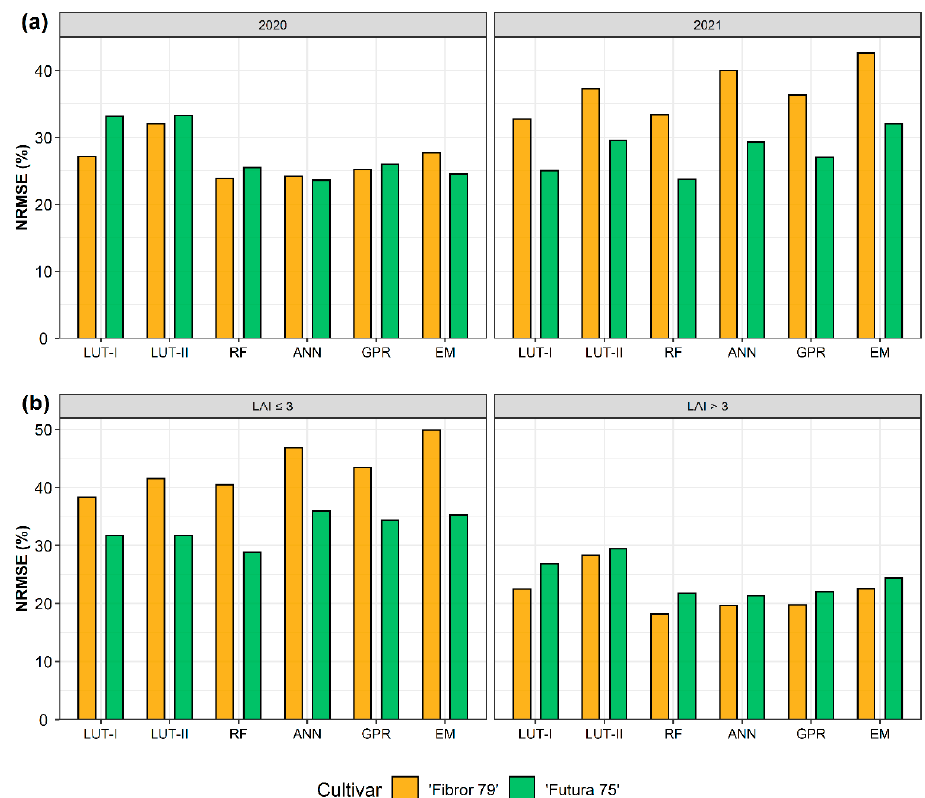
Figure 5. NRMSE values of the inversion methods for LAI estimation according to the different cultivars and ( a ) years and to the different cultivars and ( b ) two LAI intervals (LAI ≤ 3 m 2 m − 2 and LAI > 3 m 2 m − 2 ).